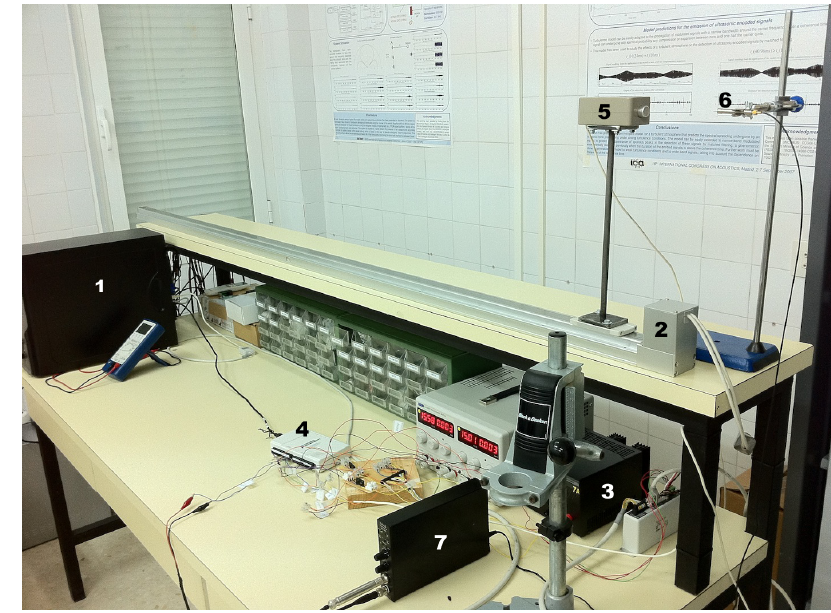
Figure 7. Experimental